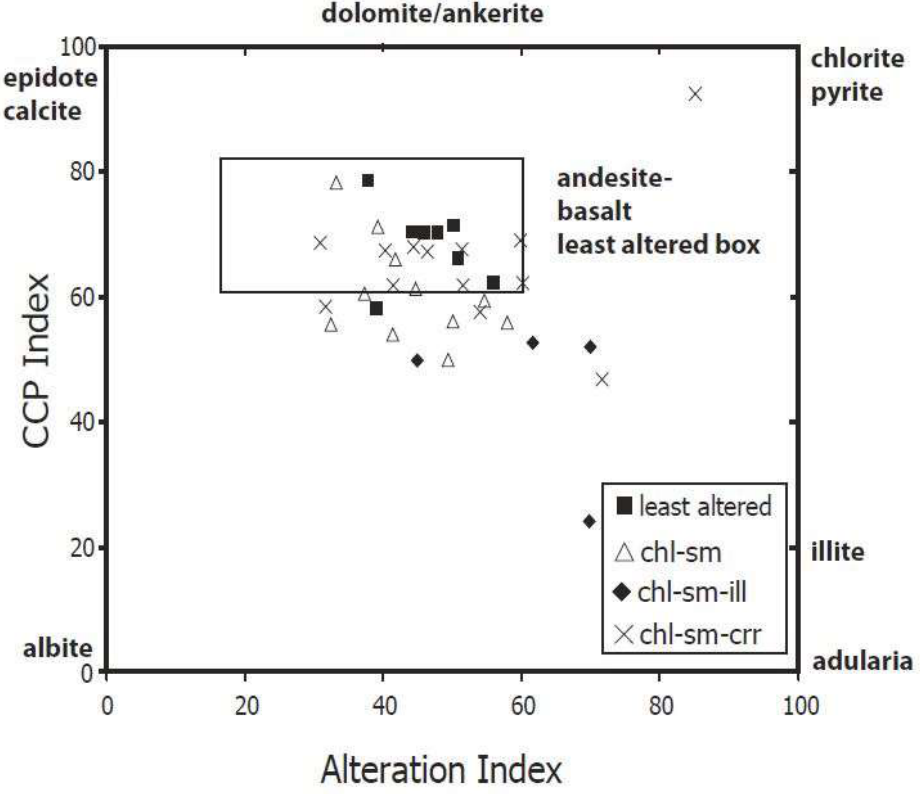
Figure 12. Alteration box plot showing samples collected from least altered and altered rocks. Altered samples dominated by chlorite (chl)–smectite (sm), chlorite–smectite–illite (ill), and chlorite–smectite– corrensite (corr) are indicated along with least-altered andesite-basalt box.